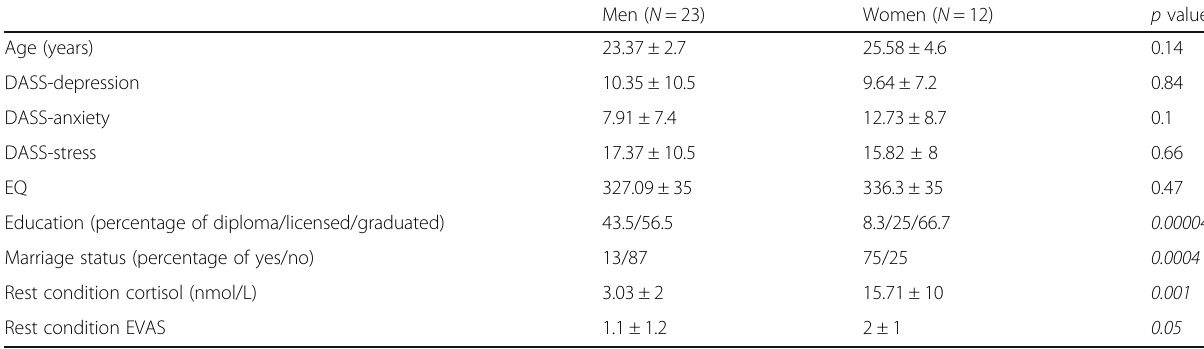
Table 1 The comparison of demographic and psychological characteristics and cortisol level between two